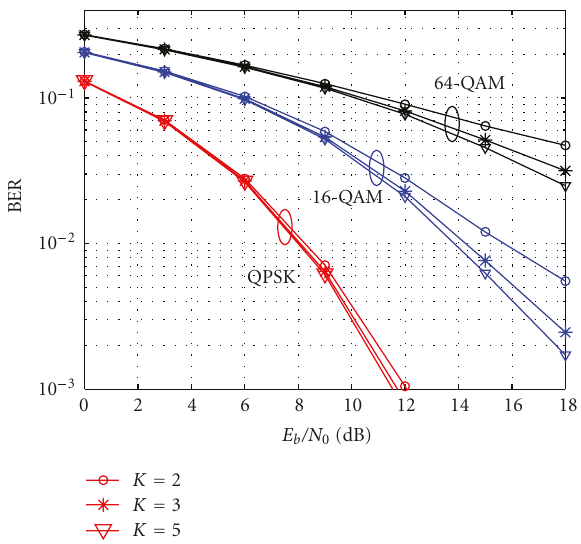
Figure 10: Uncoded BER performance for FB-FSE with ML based channel estimation using di ff erent training sequence lengths with QPSK, 16-QAM, and 64-QAM modulations. AP-FBEQ Case 3 equalizer with 2 M = 256 subbands and overlapping factor K = 5 was